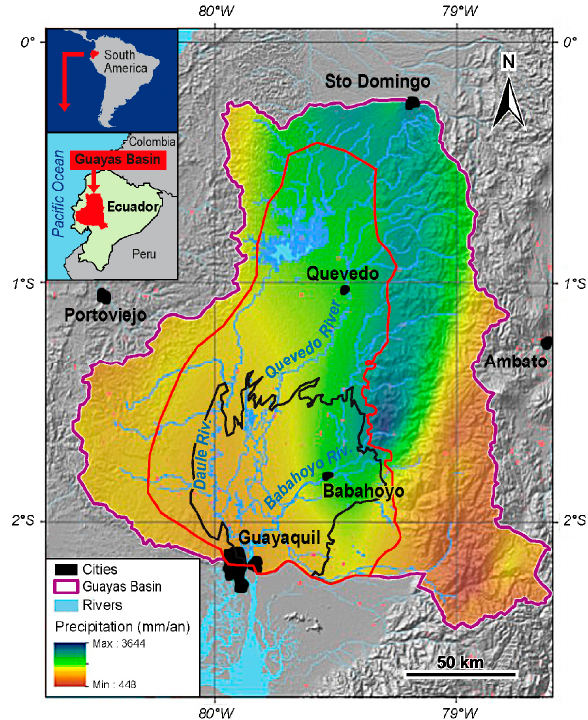
Figure 1. The Guayas Basin (boundary in purple) is located in the southwest Pacific slope of Ecuadorian Andes. The lowland (boundary in red) occupies 15,000 km 2 of the 32,300 km 2 of the watershed area, and the floodplain 5000 km 2 . The mean annual rainfall isohyets map was elaborated for the 1963–2009 period using cokriging method.